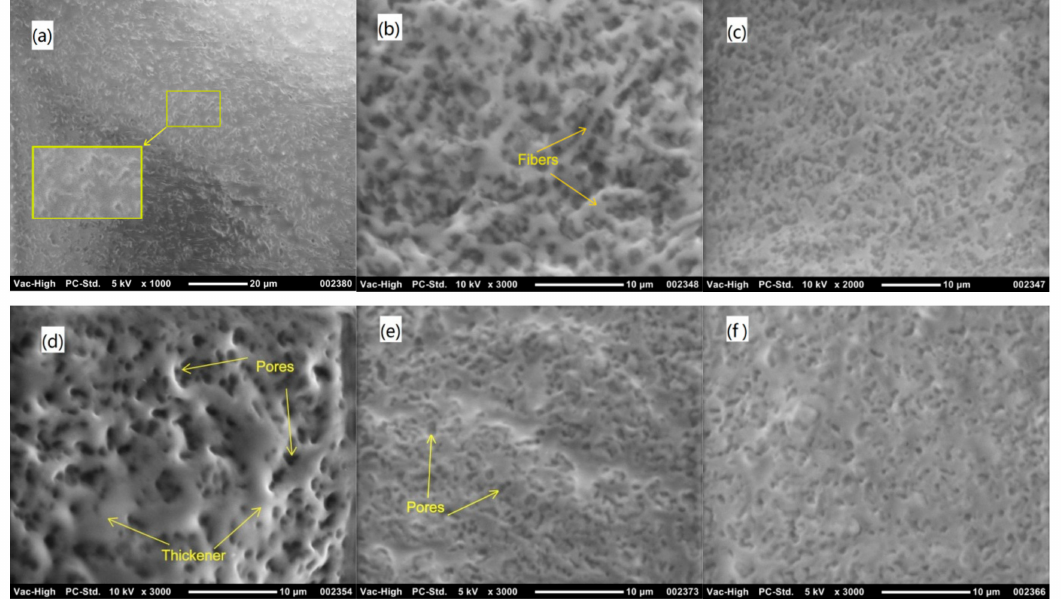
Figure 6. SEM images of thickener and base oil mixture: ( a ) M0; ( b ) R0; ( c ) R1; ( d ) R2; ( e ) R3; ( f )